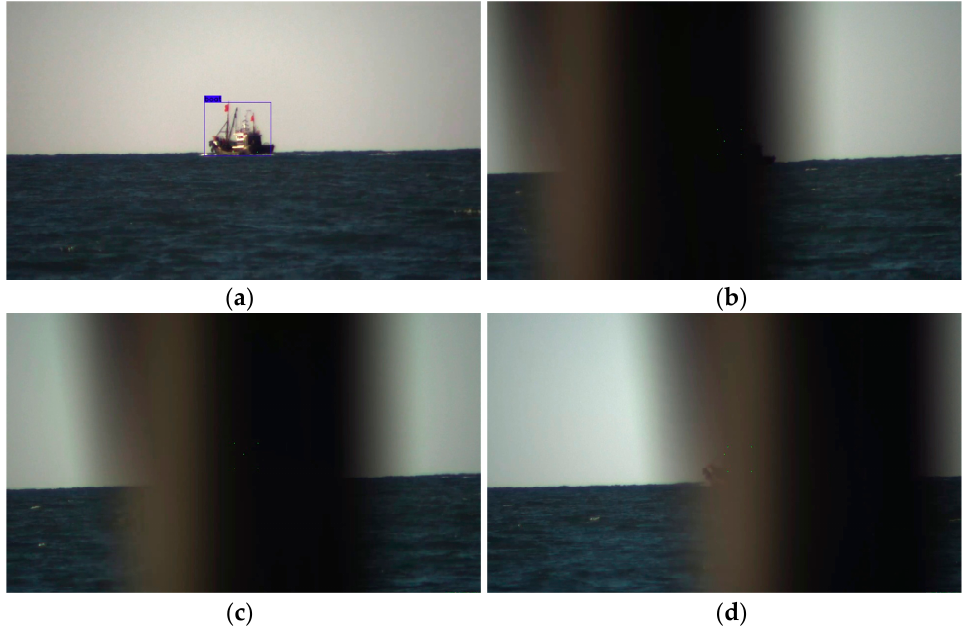
Figure 7. Images of the mast-obscuration scene: ( a ) A scene before the object is obscured; ( b ) The scene 1 where the object is obscured; ( c ) The scene 2 where the object is obscured; ( d ) The scene 3 where the object is obscured.